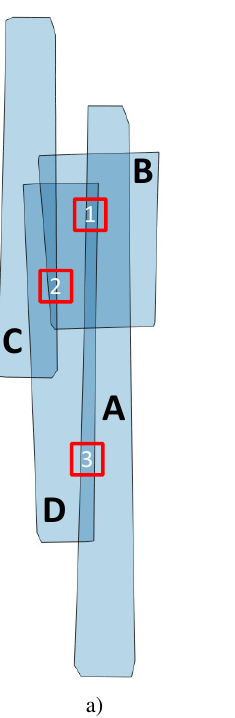
Figure 4: a) Exemplary block of four HRSC image strips